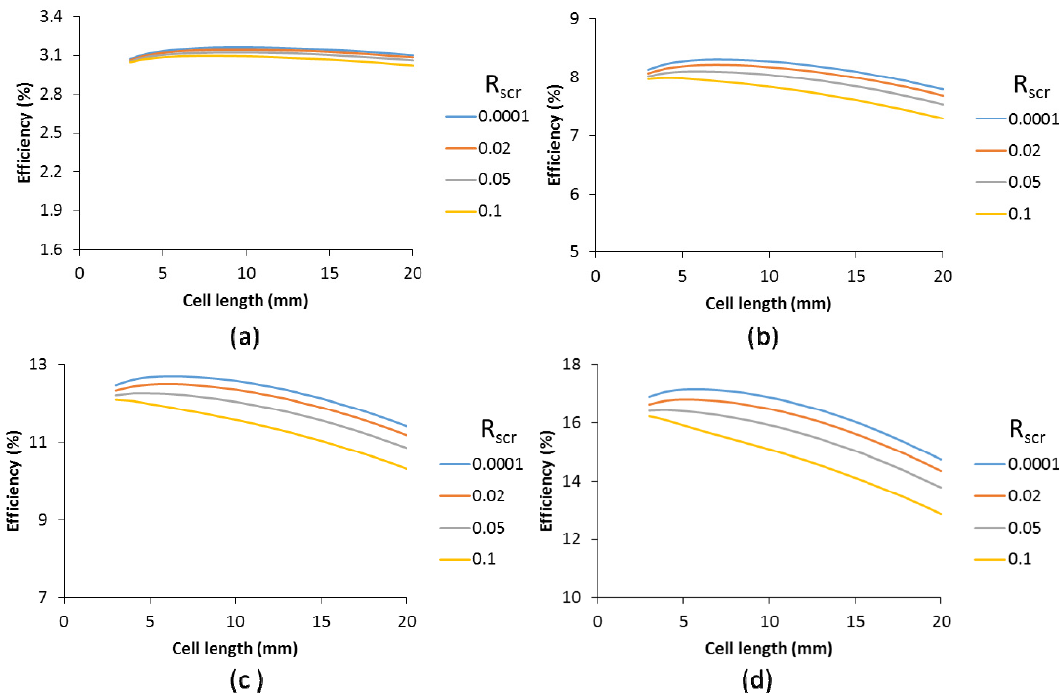
Figure 13. Efficiency as function of the cell length for various specific contact resistances (R scr , in Ohm cm 2 ) for light intensity of: 0.2 sun ( a ); 0.5 sun ( b ); 0.75 sun ( c ); and 1 sun ( d ).